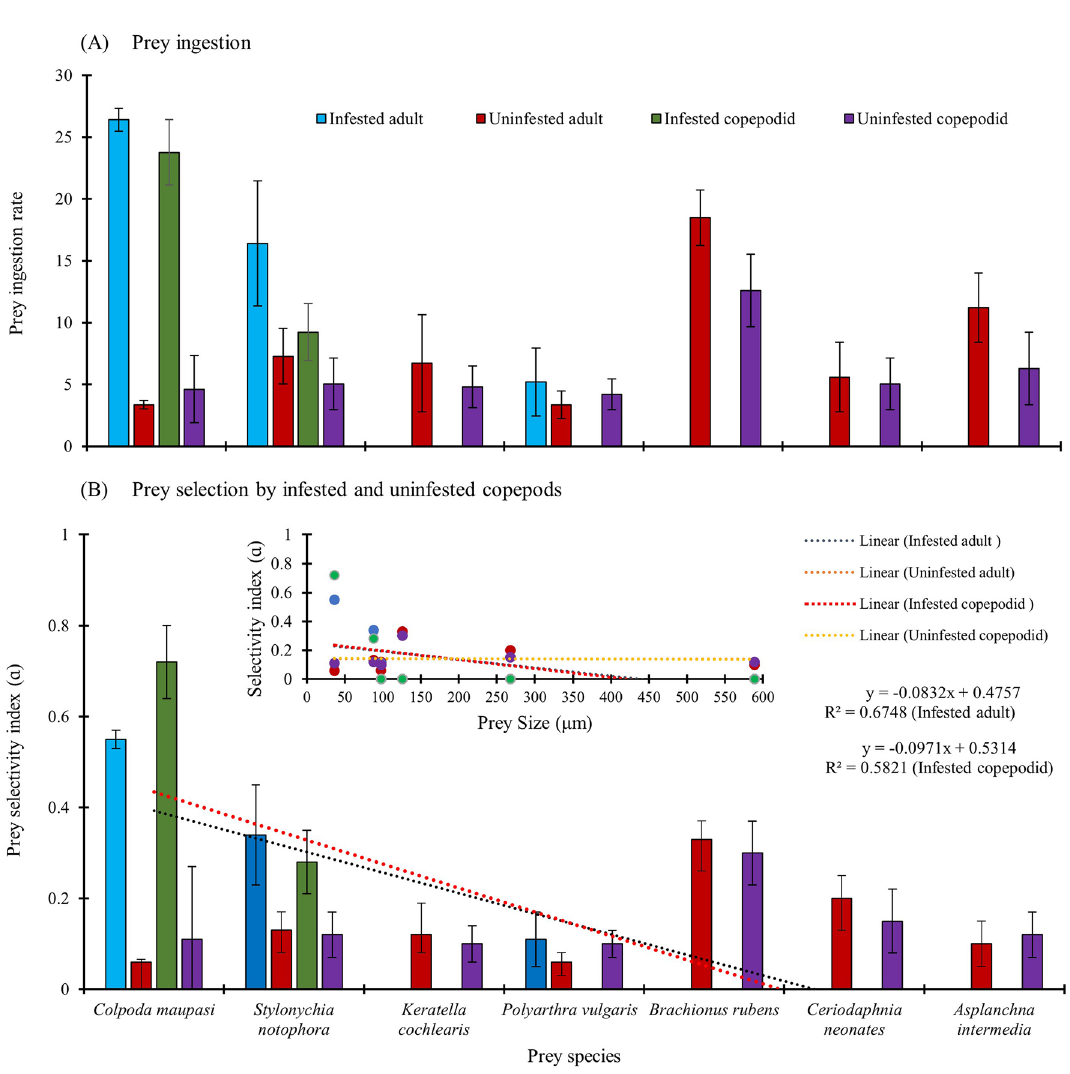
Figure 5. Prey ingestion rate ( A ), prey selectivity index value ( ɑ ) and prey selectivity as a function of body size ( B ) of Mesocyclops given a choice of ciliate, rotifer and cladoceran prey in the laboratory (see Table 1 for prey